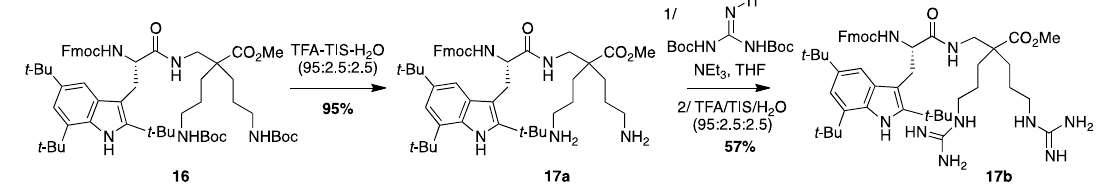
Figure 19. HPLC profile of Fmoc-Tbt- β 2,2 - h -bis-Arg-OMe 17b . Figure 19 . HPLC profile of Fmoc-Tbt- β 2,2 -h-bis-Arg-OMe 17b .